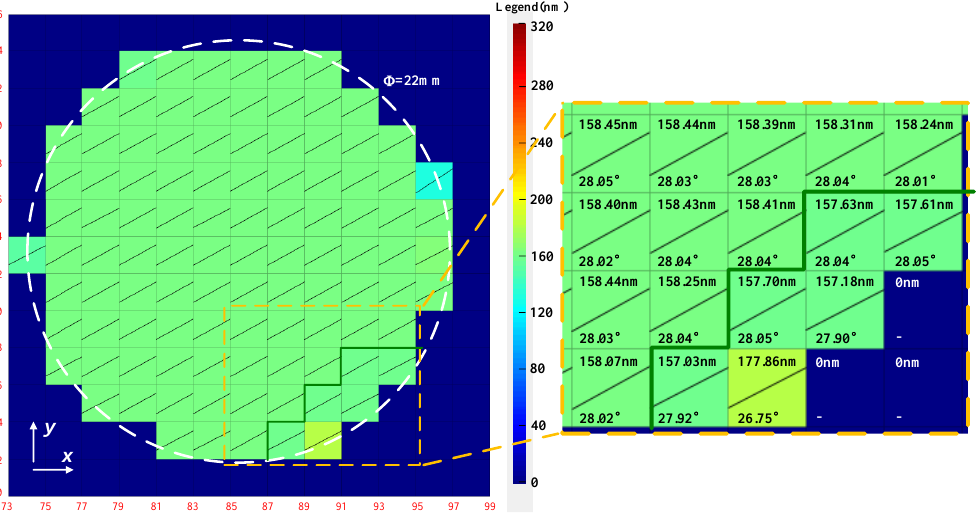
Figure 6. The 1/4 waveplate parameters measurements results for the entire aperture.